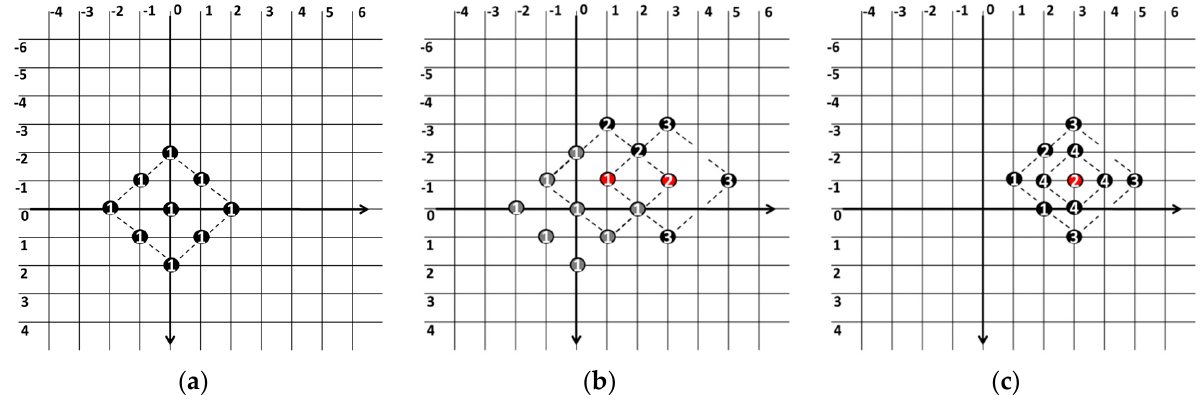
Figure 3. ( a ) A large diamond search pattern (LDSP) at search window centre, ( b ) new LDSPs are applied at minimum distortion search points if the minimum distortion search point is not at the centre of the LDSP, ( c ) a small diamond search pattern (SDSP) at the centre of the LDSP. The minimum search point at any search step is highlighted with red colour.